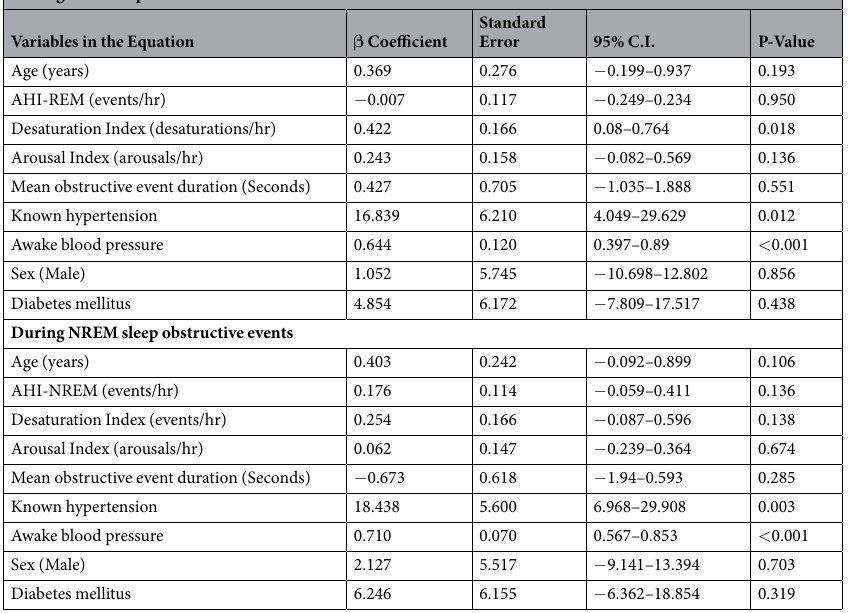
Table 6. Linear regression analysis to predict systolic blood pressure during REM and NREM sleep (n = 32). (Enter Method).